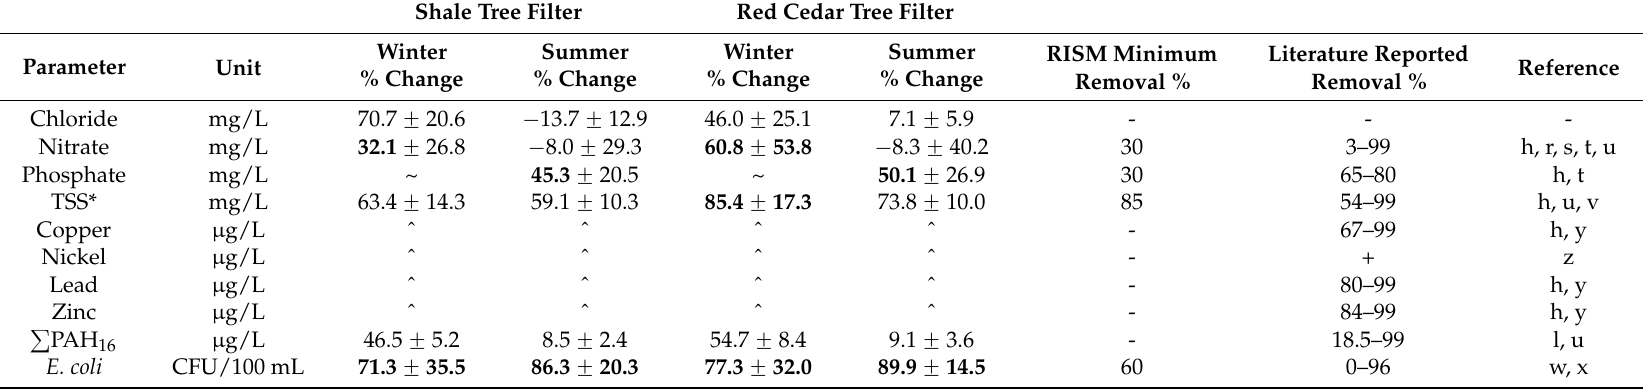
Table 4. Summary of winter and summer average changes in TF influent and effluent concentrations along with TF removal rates, literature reported removal values, Rhode Island Stormwater Manual (RISM) minimum removal requirements and StormTree © reported removal values for the parameters of interest. Bolded values meet or exceed RISM minimum removal percentages for the given